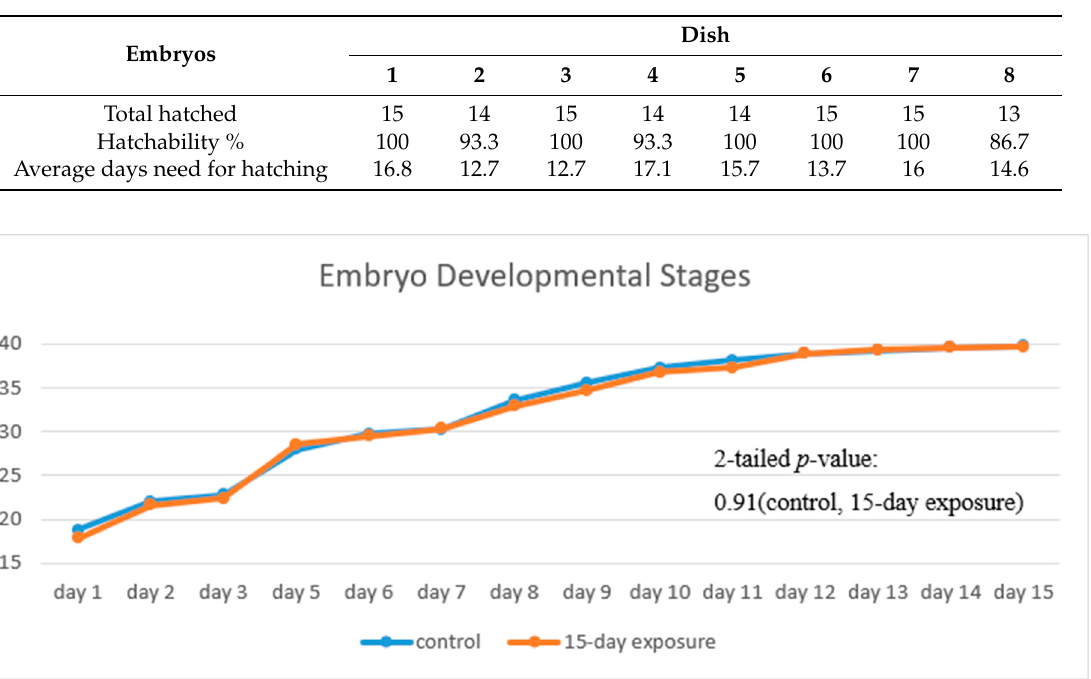
Figure 8. Stages of embryos development of the treated group with 15 days exposure in comparison with the typical stages of the control groups. Int. J. Environ. Res. Public Health 2019 , 16 , x